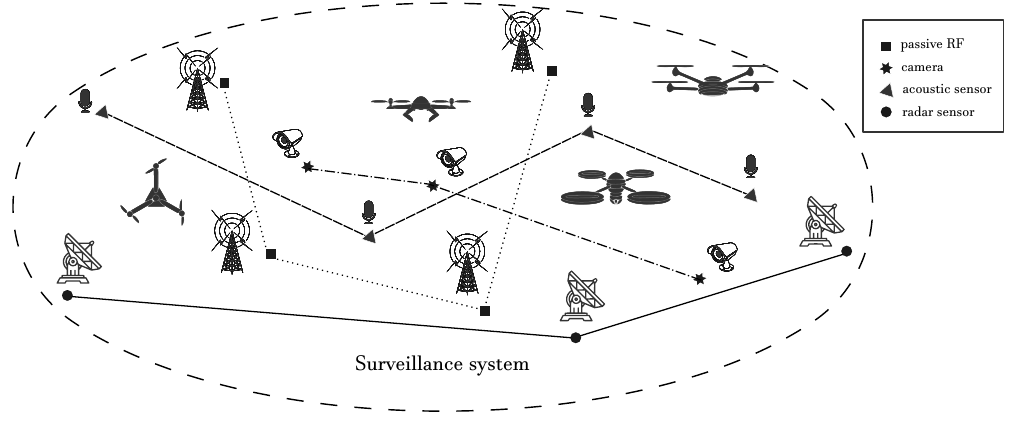
Figure 2. Heterogeneous drone surveillance